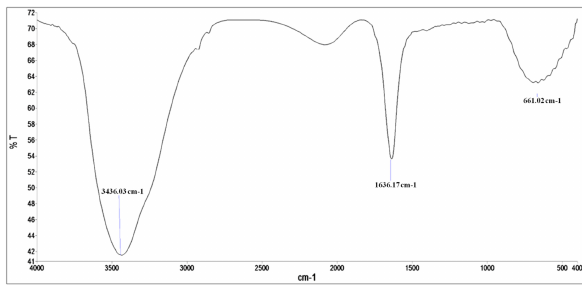
Figure 3. FTIR spectra of AgNPs synthesized by the C. glabrata supernatant.